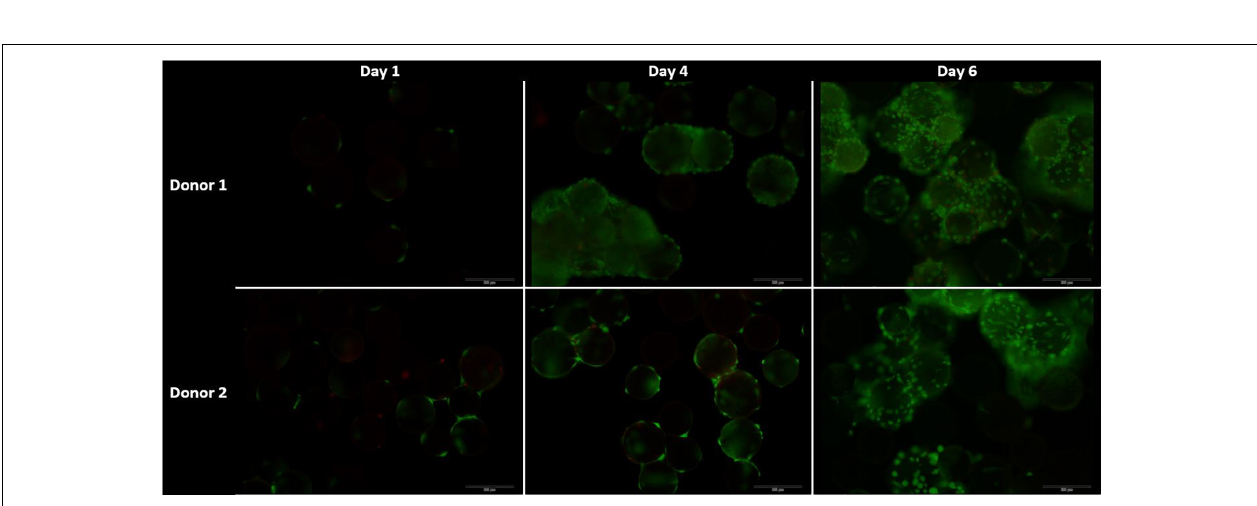
FIGURE 9 | Live dead stainings for the dynamic Star-Plus evaluation on day 1, 4, and 8 for both donor 1 and donor 2. Live cells are stained green by calcein and dead cells are stained red by ethidium.